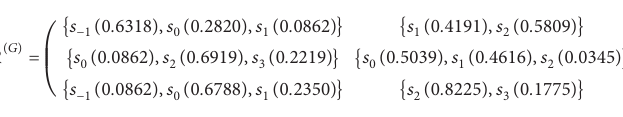
e l on emergency